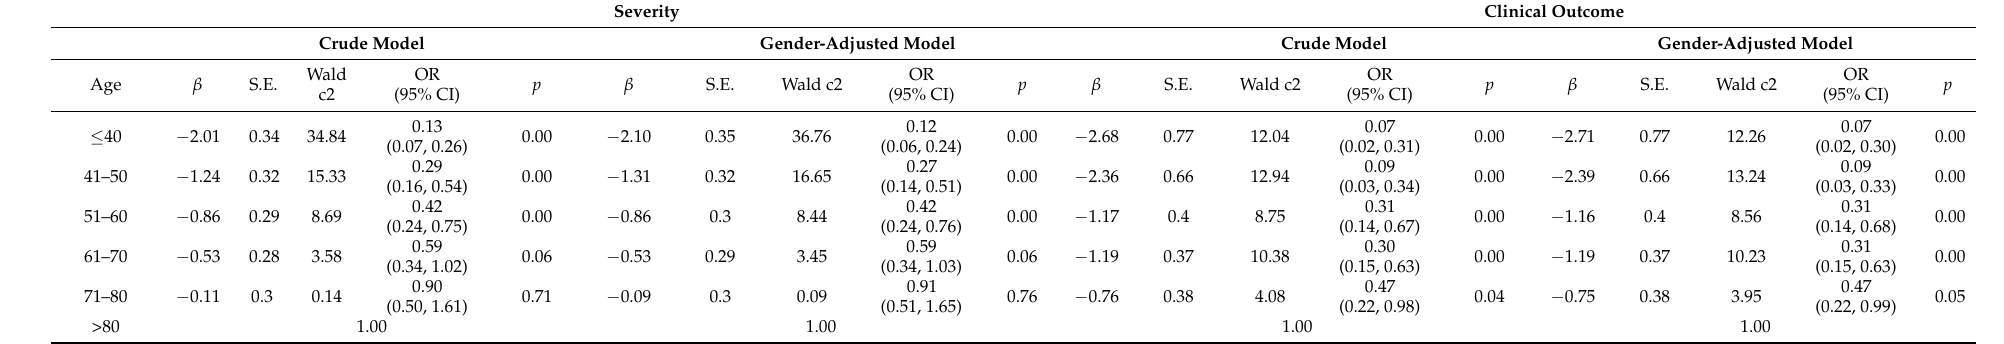
Table 3. The logistic regression parameter of severity and clinical outcome in association with the age among diagnosed COVID-19 patients. Severity Clinical Outcome Crude Model Gender-Adjusted Model Crude Model Gender-Adjusted